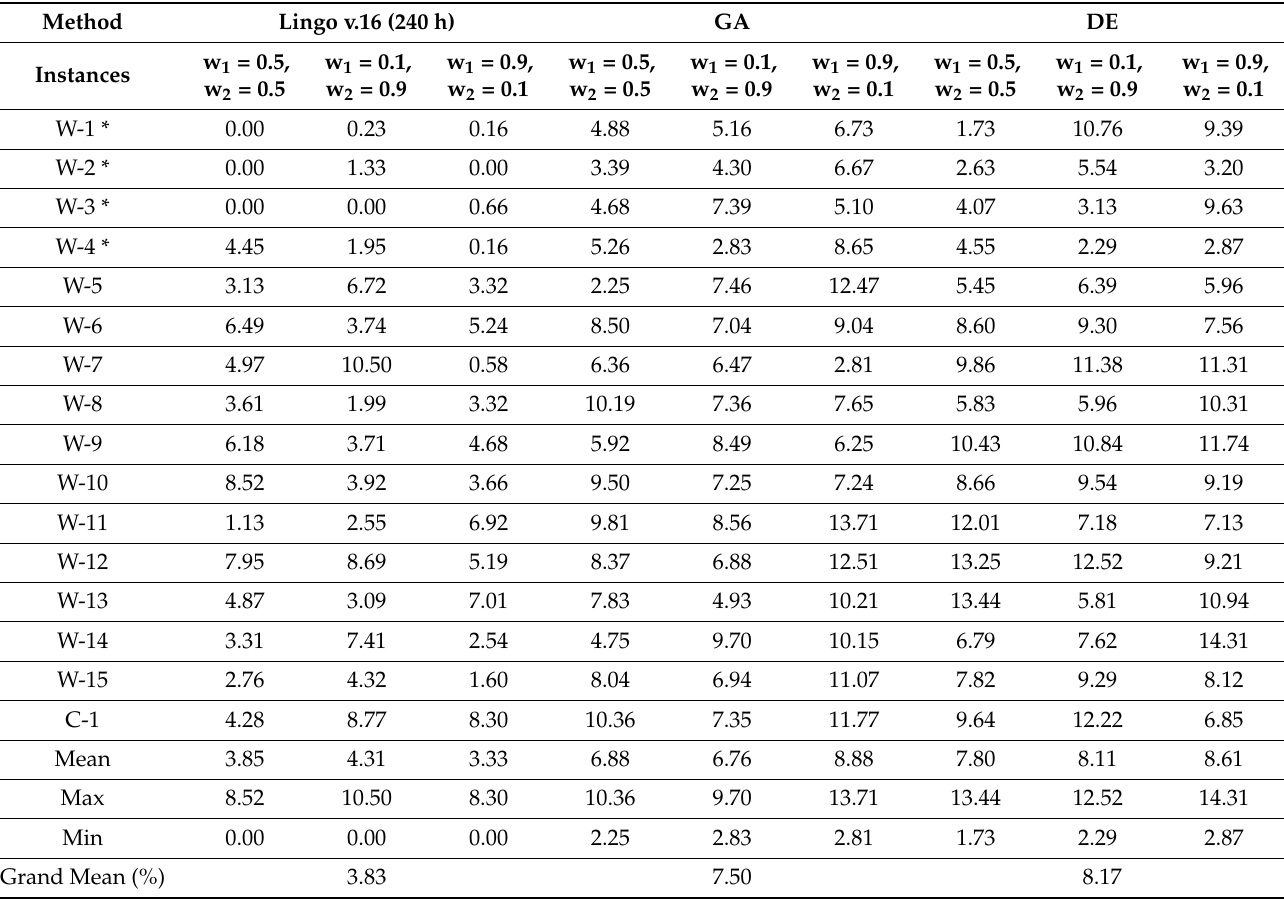
Table 8. % difference between AMIS and other